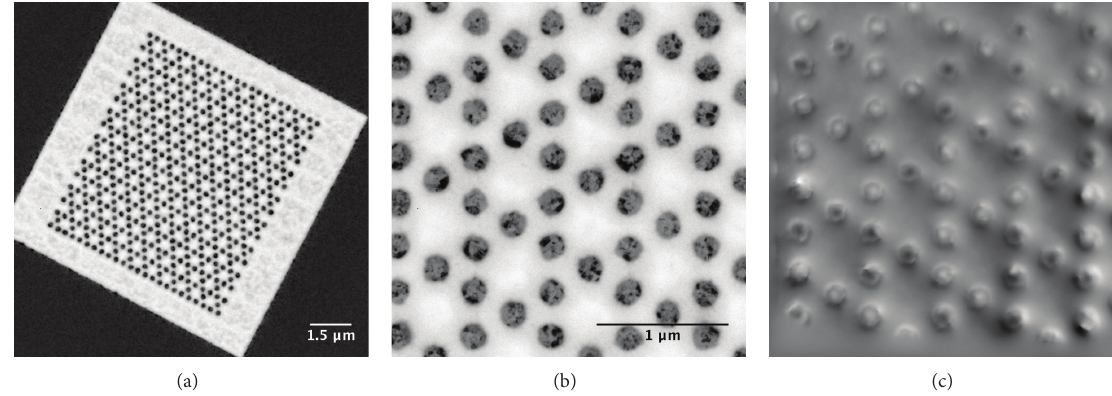
Figure 4: Bright field TEM images of magnetic islands milled out of a thin film using raster style scanning (pattern was defined by a bitmap imageofthedesign)((a)and(b)),andtheircorrespondingphaseshiftimage(c)reconstructedbyusingtransport-of-intensitytechniqueshows the islands supporting magnetic vortex states. The dark and bright spots at the center of the islands relate to clockwise/counterclockwise rotation of magnetization. From Ch. Phatak, Argonne National Laboratory, Materials Science Division, presented at the 54th EIPBN conference,